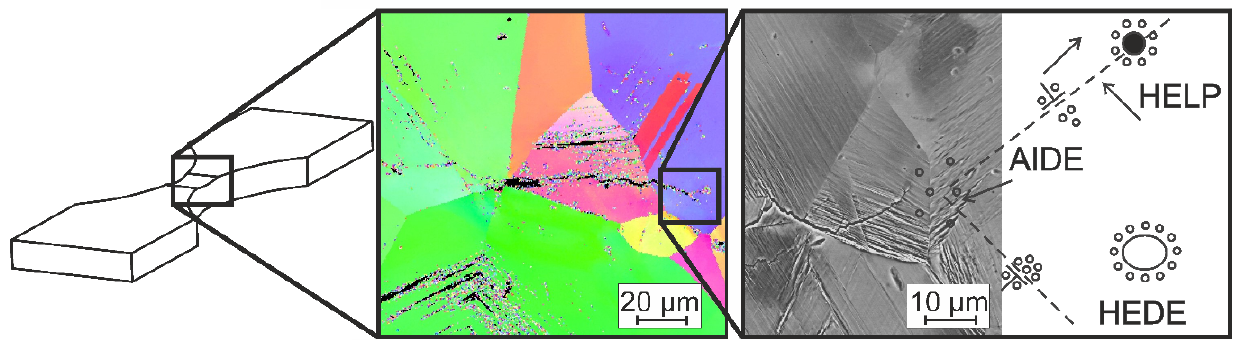
Figure 1. Schematic representation of the main mechanisms for hydrogen embrittlement.